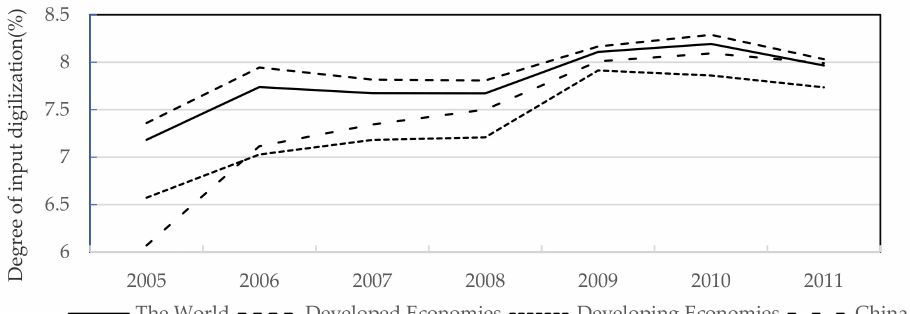
Figure 1. The trend of the manufacturing industry’s input digitization from different economies in the world.